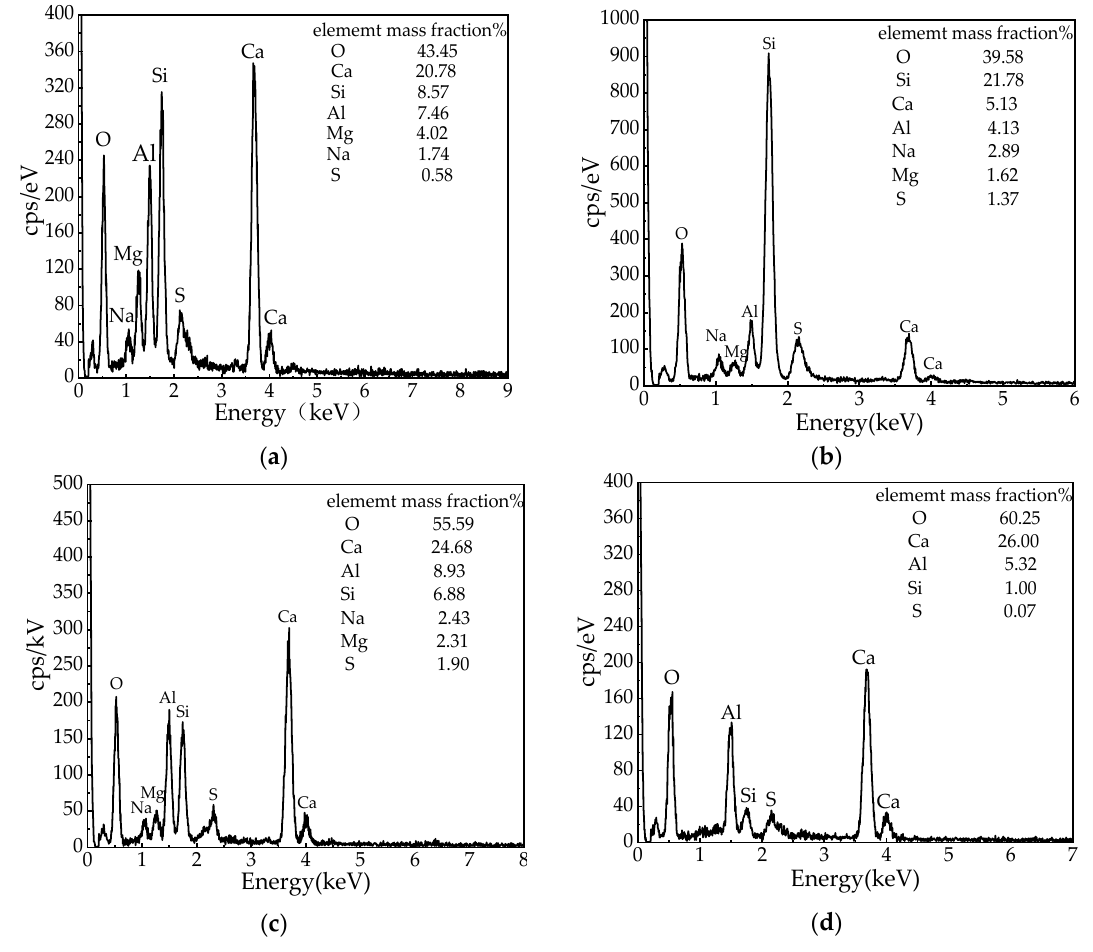
Figure 9. Energy dispersive spectroscopy (EDS) energy spectrum analysis: ( a ) EDS analysis of slag, ( b ) EDS analysis of BA, ( c ) EDS analysis of C-A-S-H, ( d ) EDS analysis of C-H.